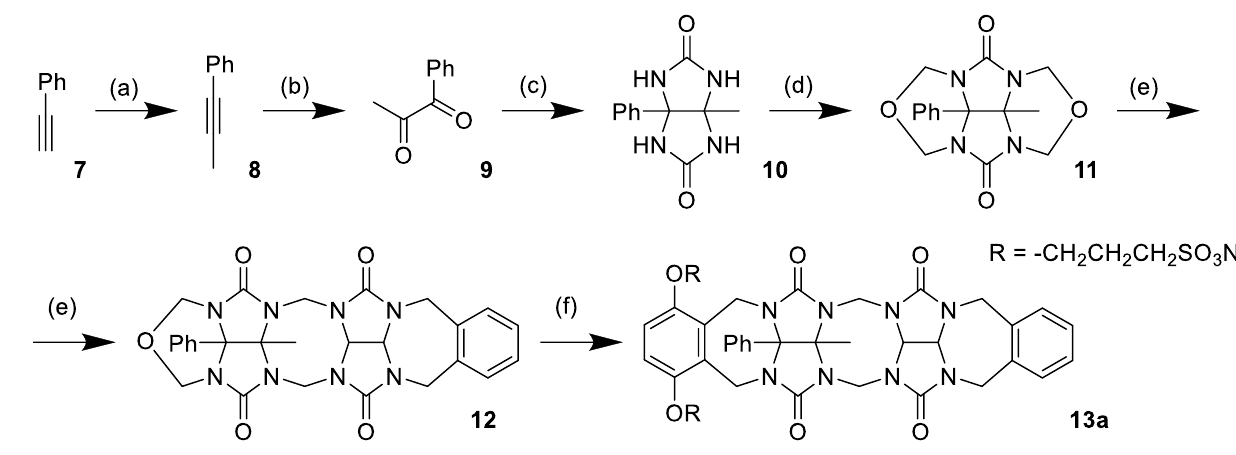
Scheme 2. Synthesis of glycoluril dimer 13a . Reaction conditions: ( a ) 1. n -BuLi, THF, −78 °C, 40 h , 2.